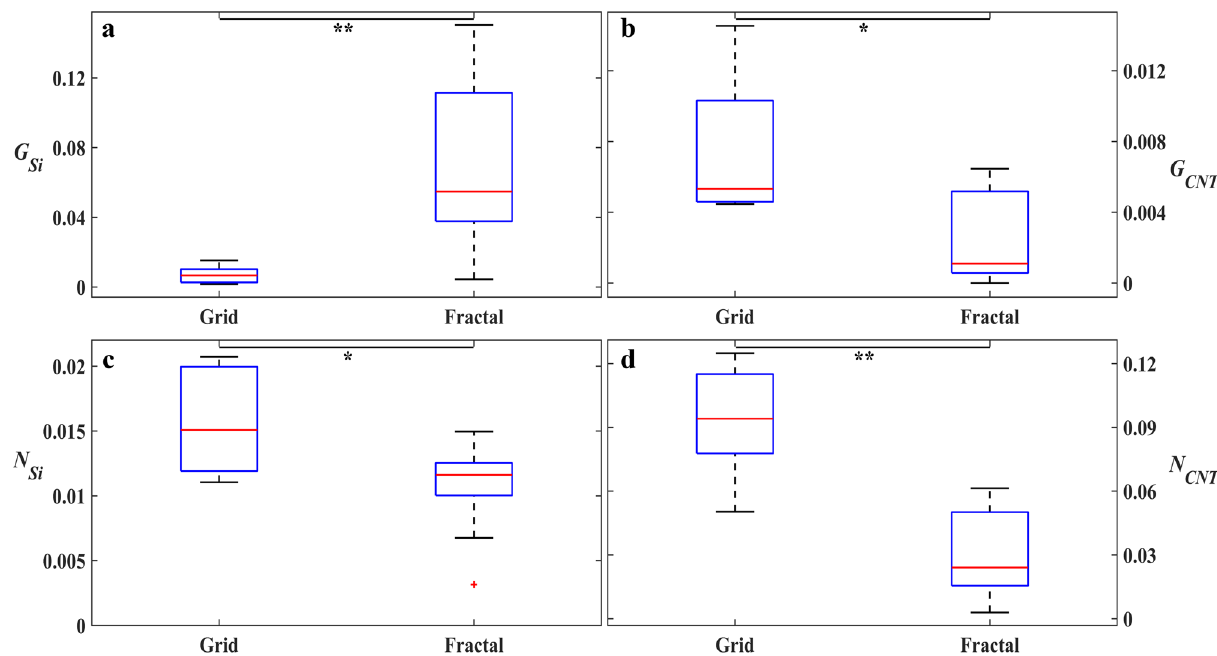
Figure 5. Comparison between the grid and fractal electrodes at 17 DIV in terms of the glial and neuronal behavior on the SiO 2 and VACNT surfaces. Statistical analysis showing boxplots of ( a ) G Si , ( b ) G CNT , ( c ) N Si , and ( d ) N CNT between the grid and fractal electrodes. Stars in all panels indicate the degrees of significance: ** and *denote p ≤ 0.01 and p ≤ 0.05, respectively. The red plus in panel ( c ) is an